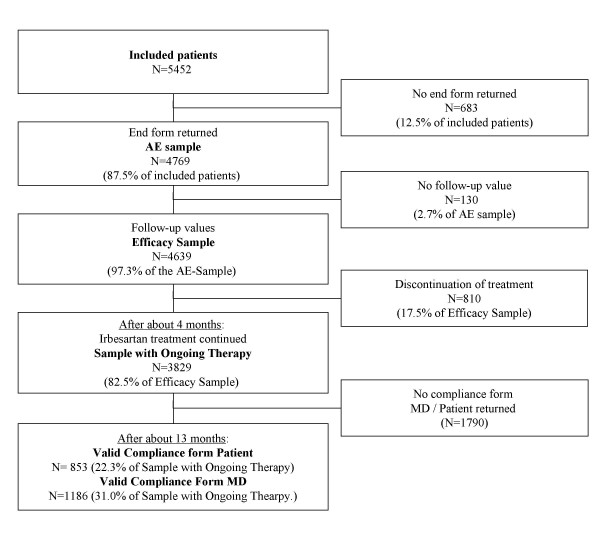
Patient population and available data. Summary of the analysis patient populations of this investigation and of the data available for analysis.